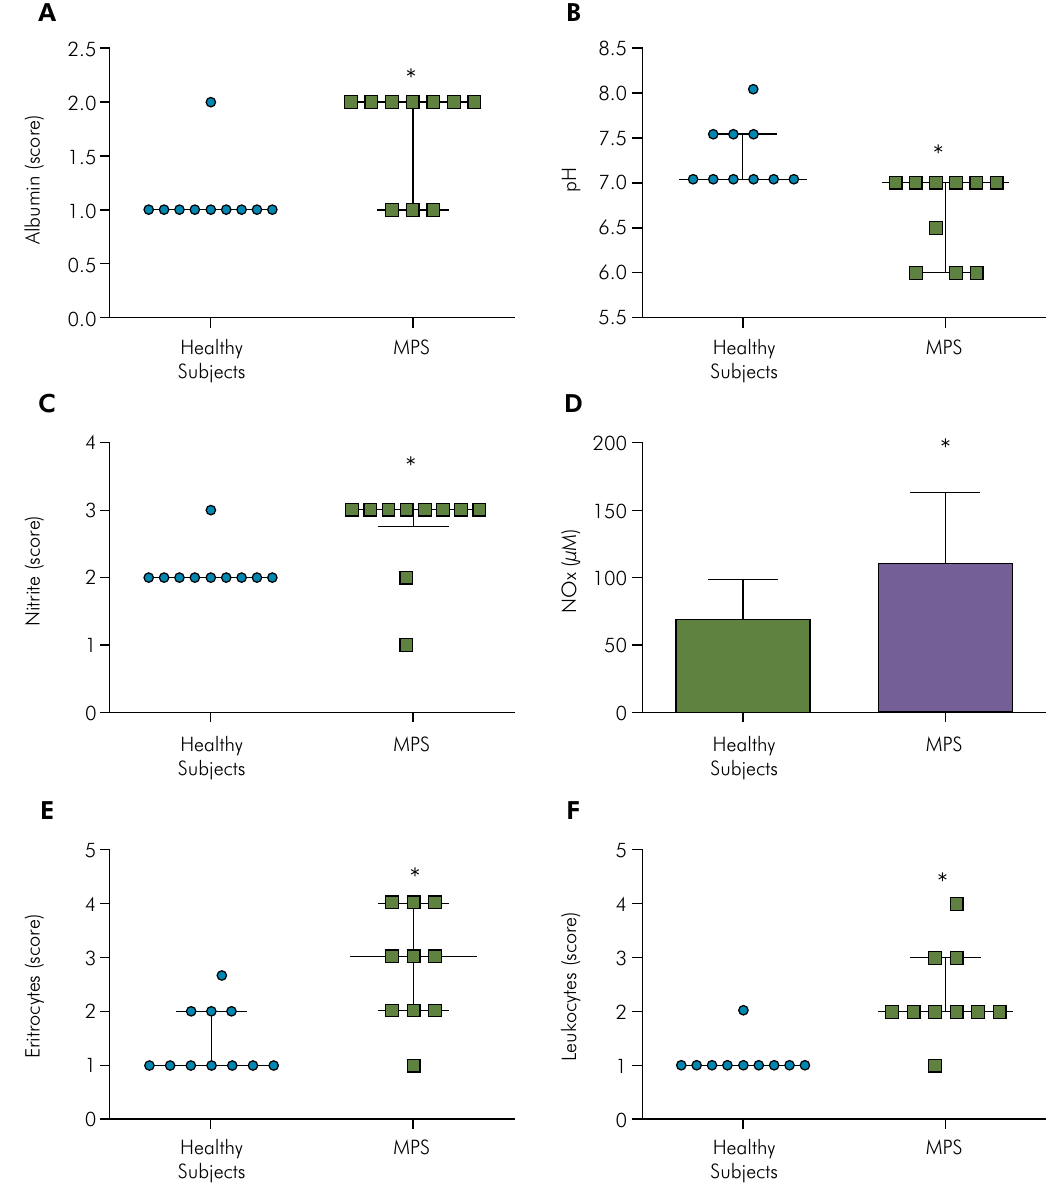
Figure. . Median and IQR values observed for albumin present in saliva (Figure A). Salivary pH median and IQR values for healthy subjects and MPS (Figure B). Amounts of nitrite observed in healthy and MPS patients (Figure C). Salivary NOx values (Figure D). Erythrocytes (Figure E) and Leukocytes (Figure F) scores in the